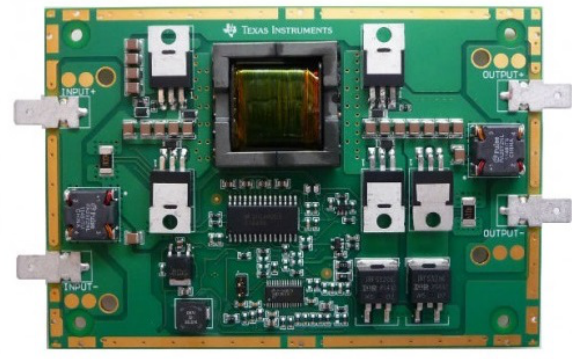
Figure 14. Texas Instruments MPPT prototyping board and typical application